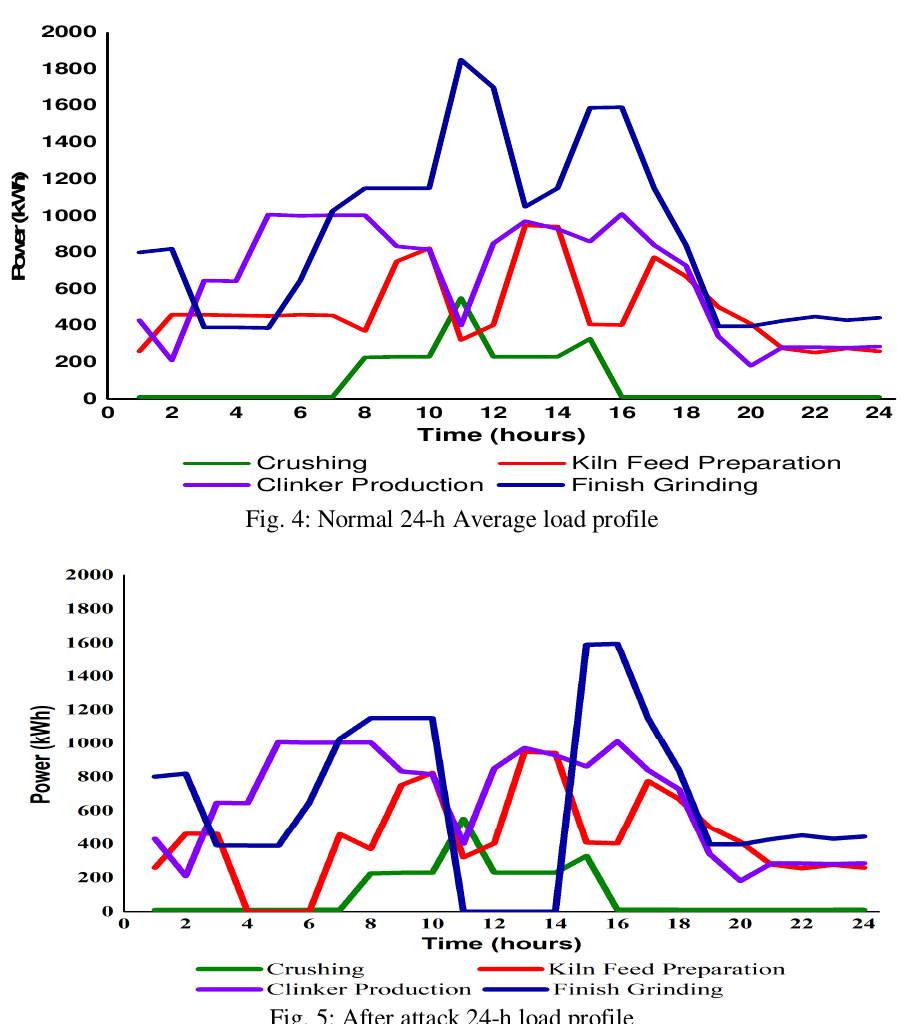
Fig. 5: After attack 24-h load